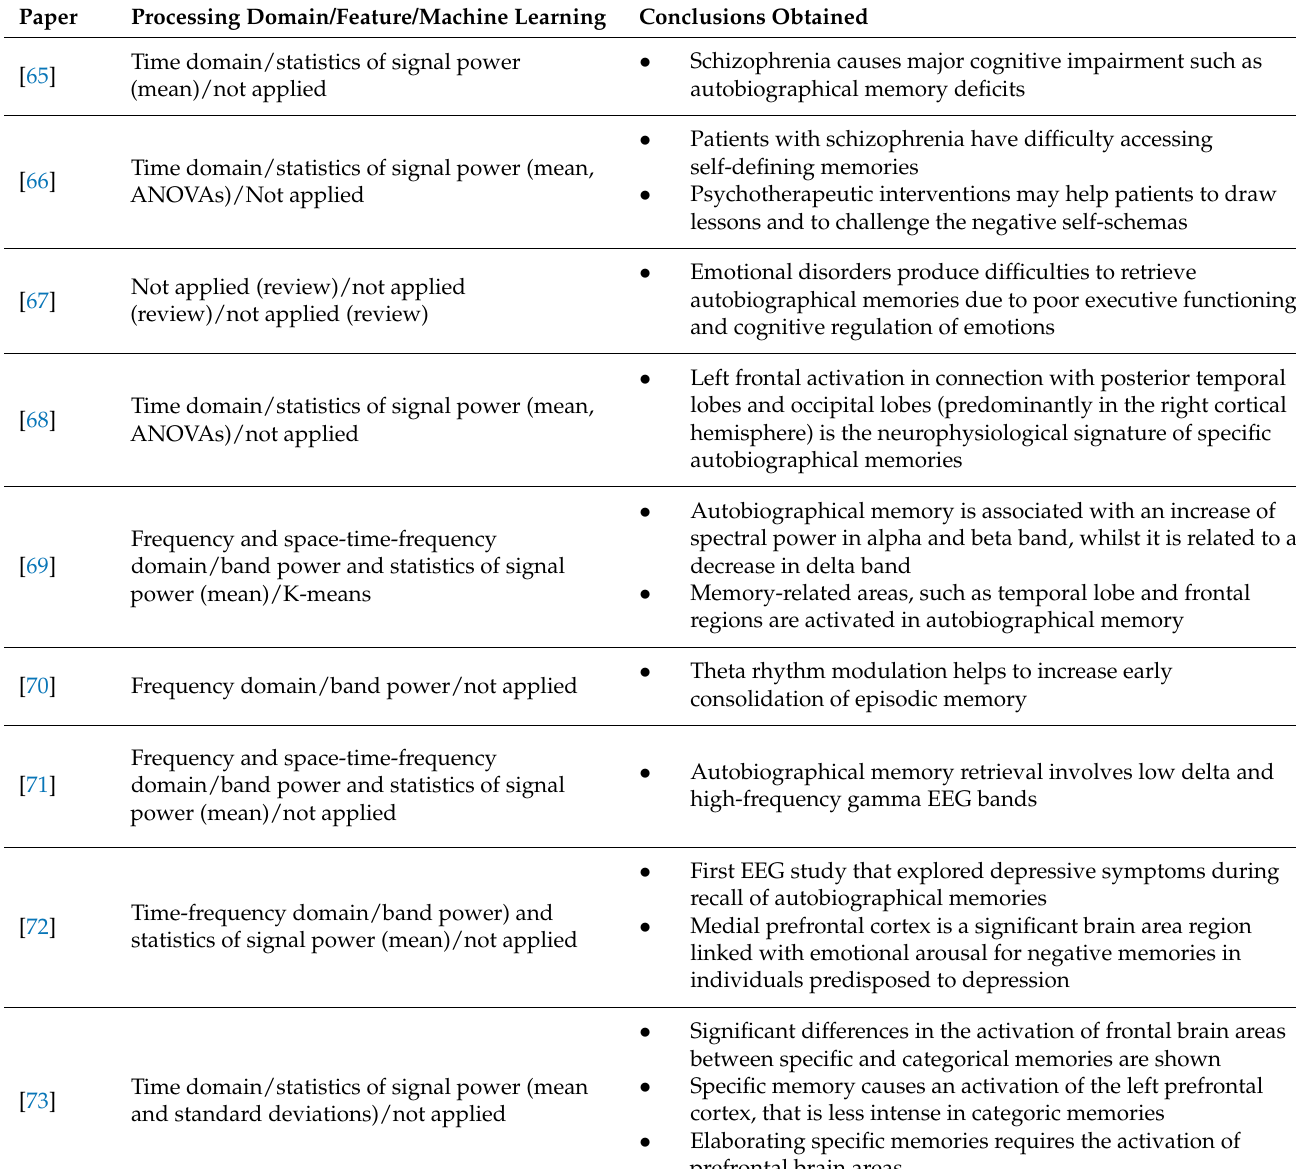
Table 6. Published research focused on EGG autobiographical